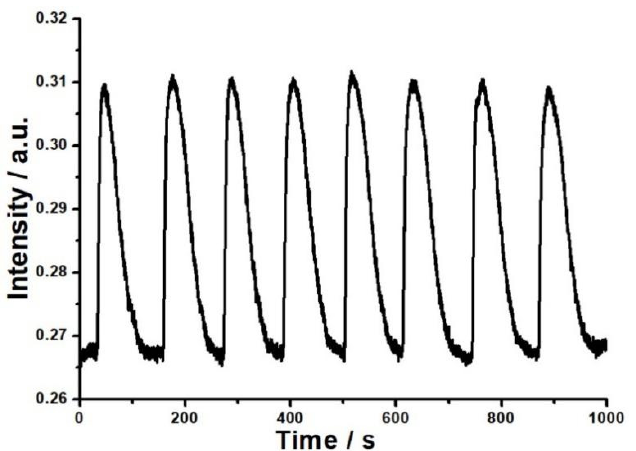
Figure 5. The reversibility of the OWG sensor to 32%RH water vapor.